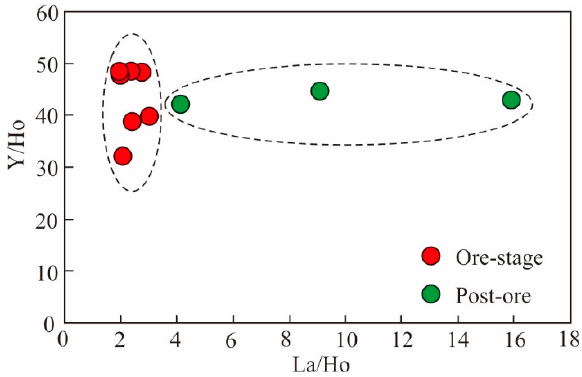
Figure 7. La/Ho vs. Y/Ho plot for calcites from the Zhesang gold deposit [48].